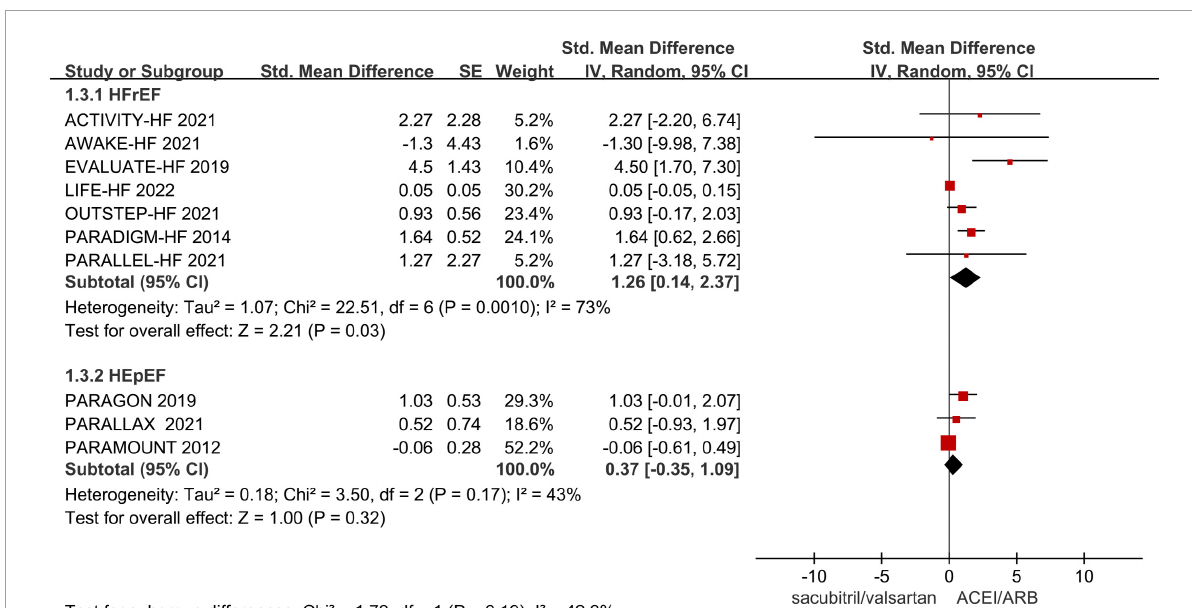
FIGURE4 Meta-analysis forest plot of change in health-related quality of life (HRQoL)